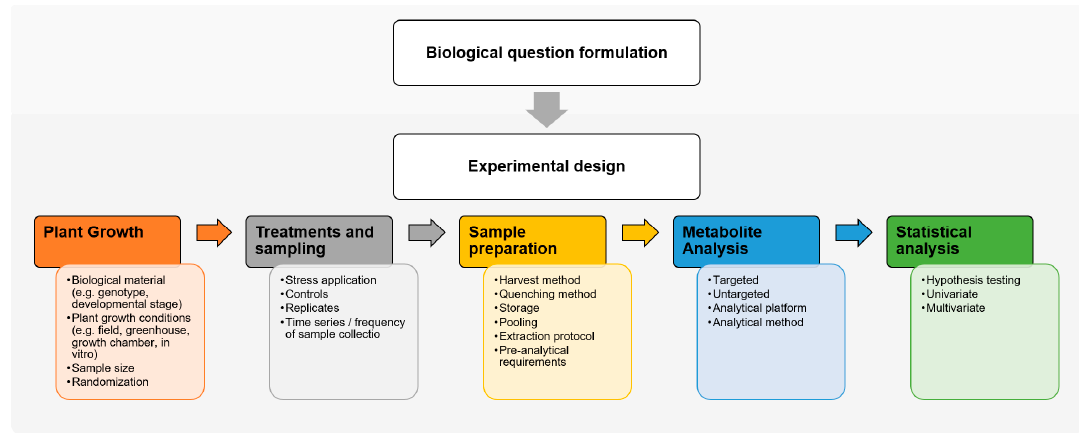
Figure 1. Experimental design and workflow in a plant metabolomics experiment.